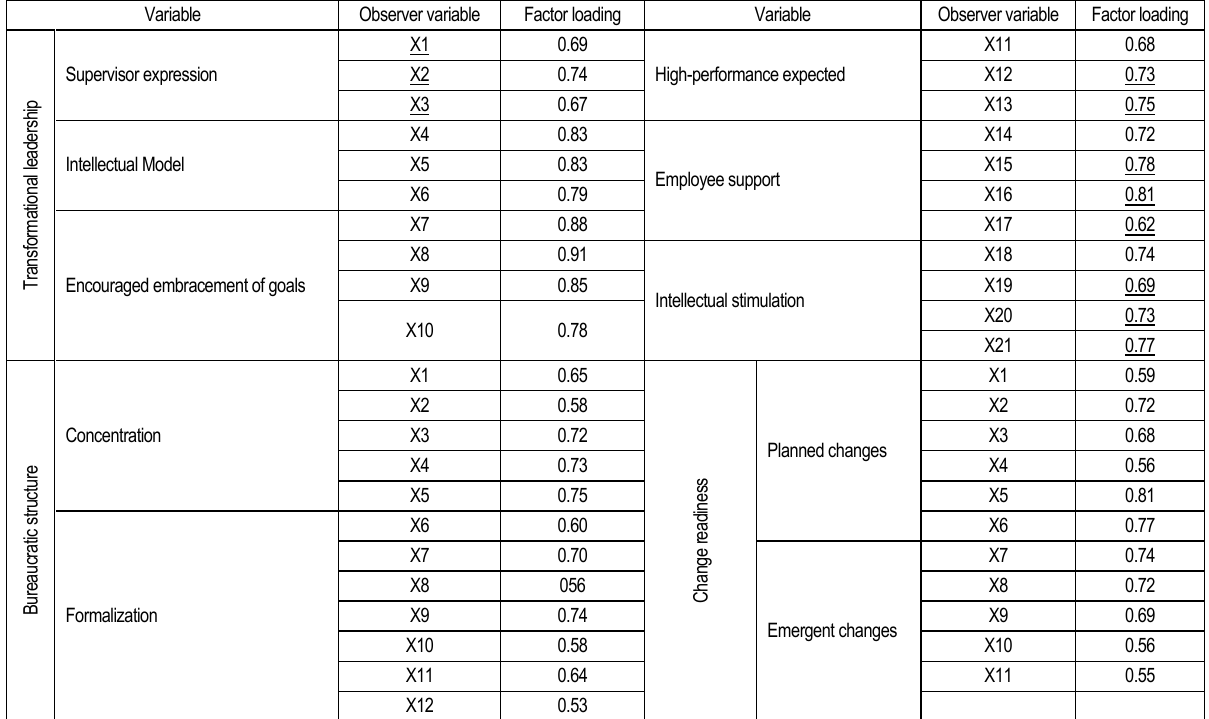
Table 2. The results of confirmatory factor